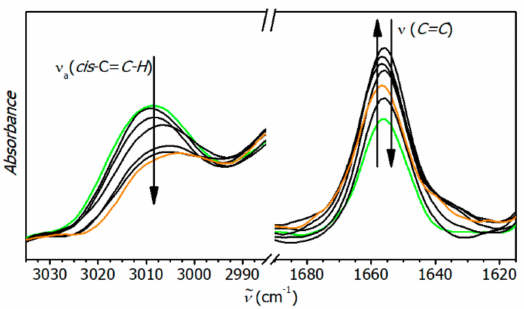
Figure 5. Development of the bands of ν a ( cis -C = C–H ) and ν ( C = C ) in the Raman spectra of Mn / S471 (Green and orange lines represent the first and the last spectrum in the series, respectively.).